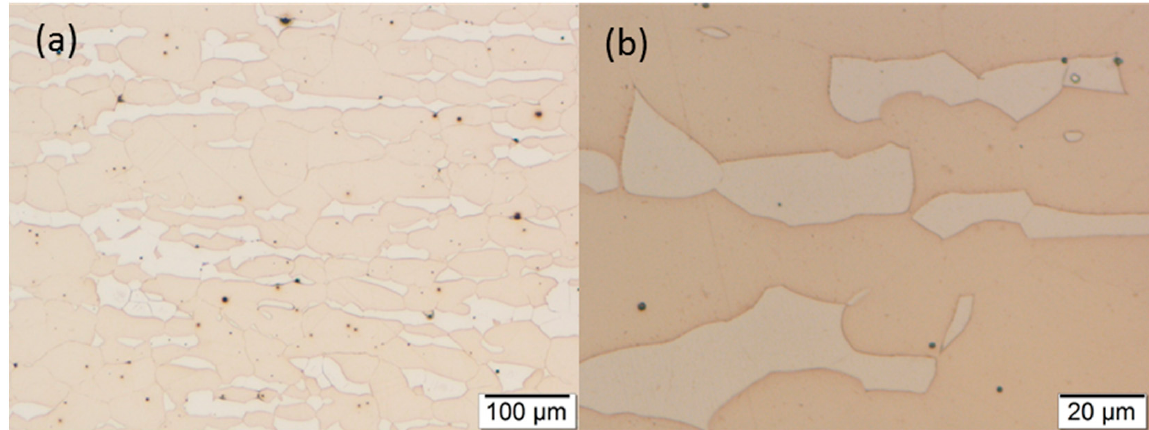
Figure 4. Optical microscopy of the as cast duplex microstructure, etched with 10% nital, ferrite––white, and austenite–– brown; ( a ) the microstructure is elongated along the hot forging direction, but there is no visible deformation remaining in the crystal grains, indicating a full recrystallization, ( b ) magnified detail, there is no precipitation on the grain bounda- ries.